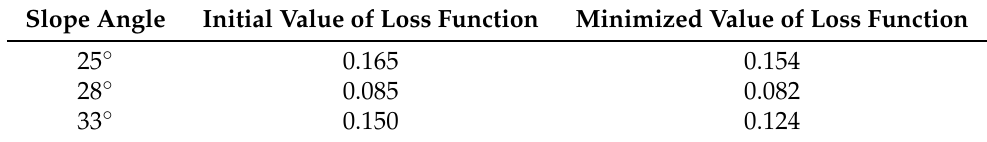
Table 4. Loss function minimization.